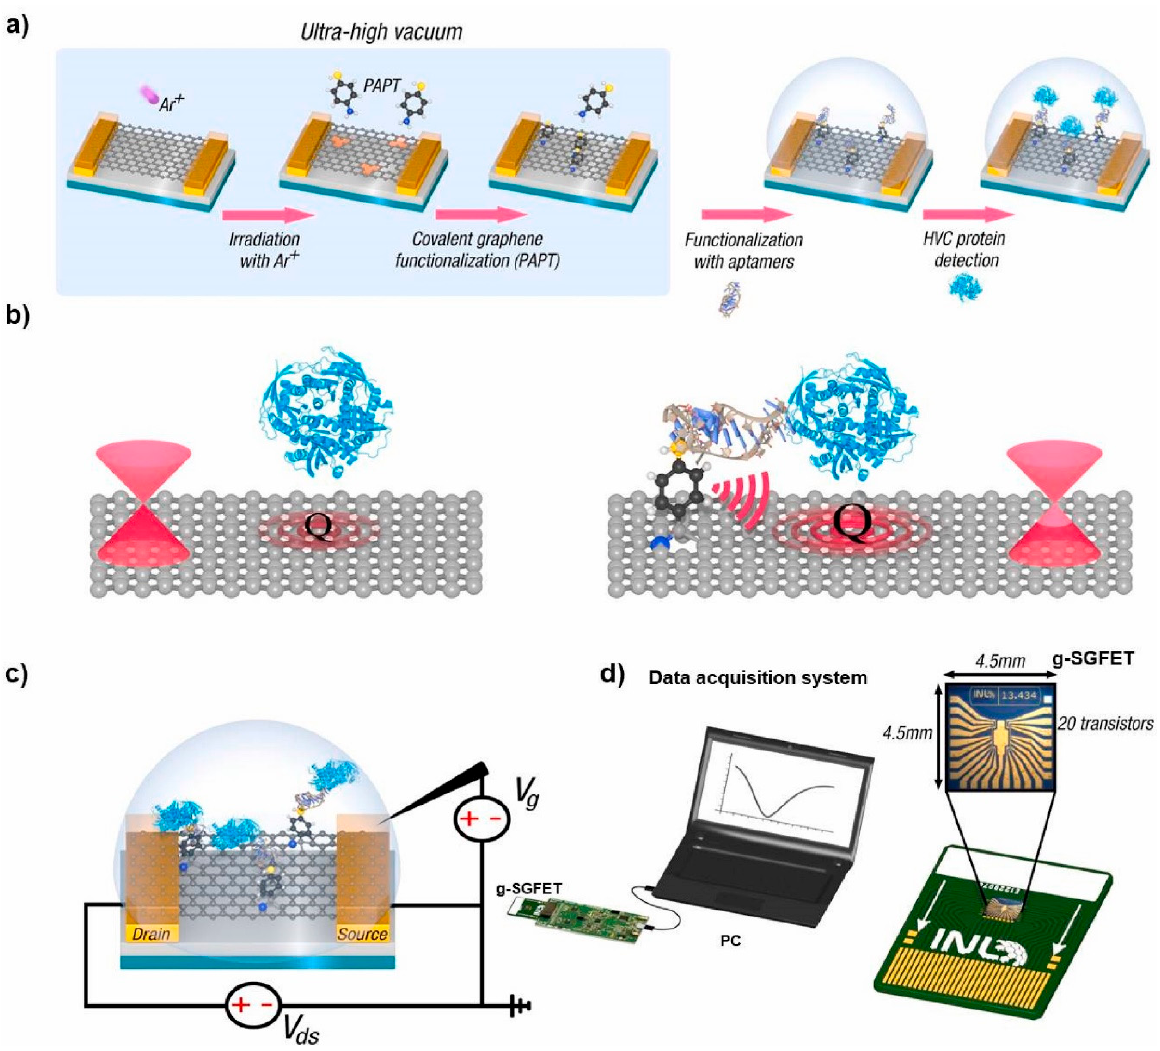
Figure 5. ( a ) Protocol to develop a covalent g-SGFET aptasensor, ( b ) molecular-antenna effect, ( c ) g-SGFET functioning scheme, and ( d ) real image and dimensions of the g-SGFET wire-bonded to a printed circuit board (PCB) inserted into an electronic platform that can communicate with a computer where the measured data are displayed [76].